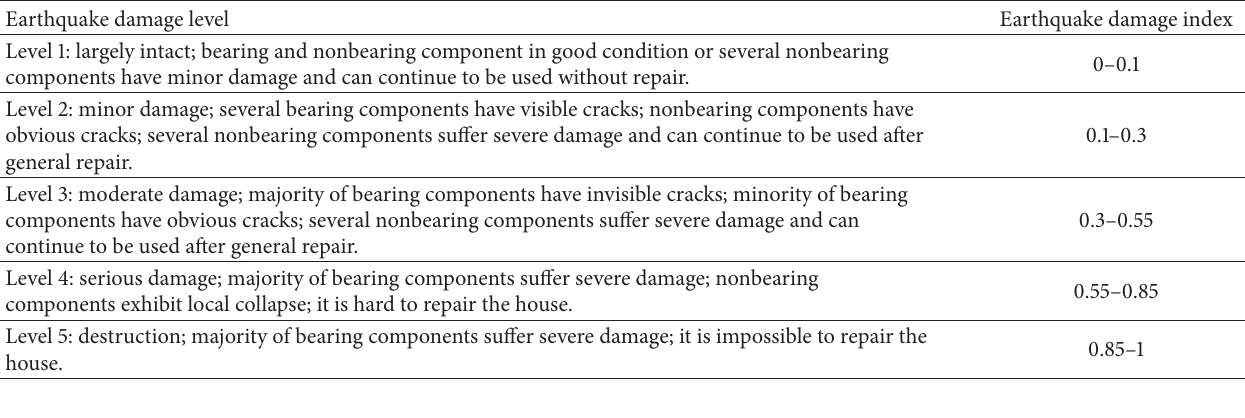
Table 5: Quantization table of earthquake damage level.